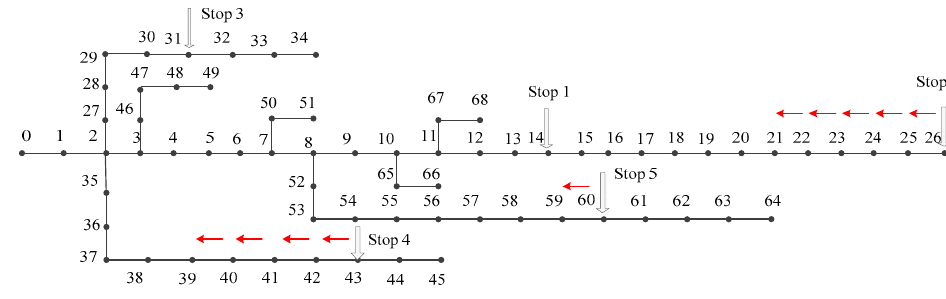
/ Table 7. Risk assessment results of branch 0–1.